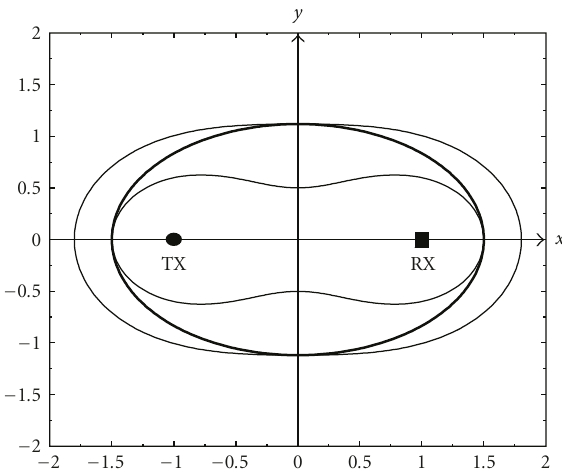
Figure 4: Received power and TOA in bistatic radar: TX and RX are in ( − 1,0) and (1,0), the thick line is an equi-TOA ellipse, the others are Cassini